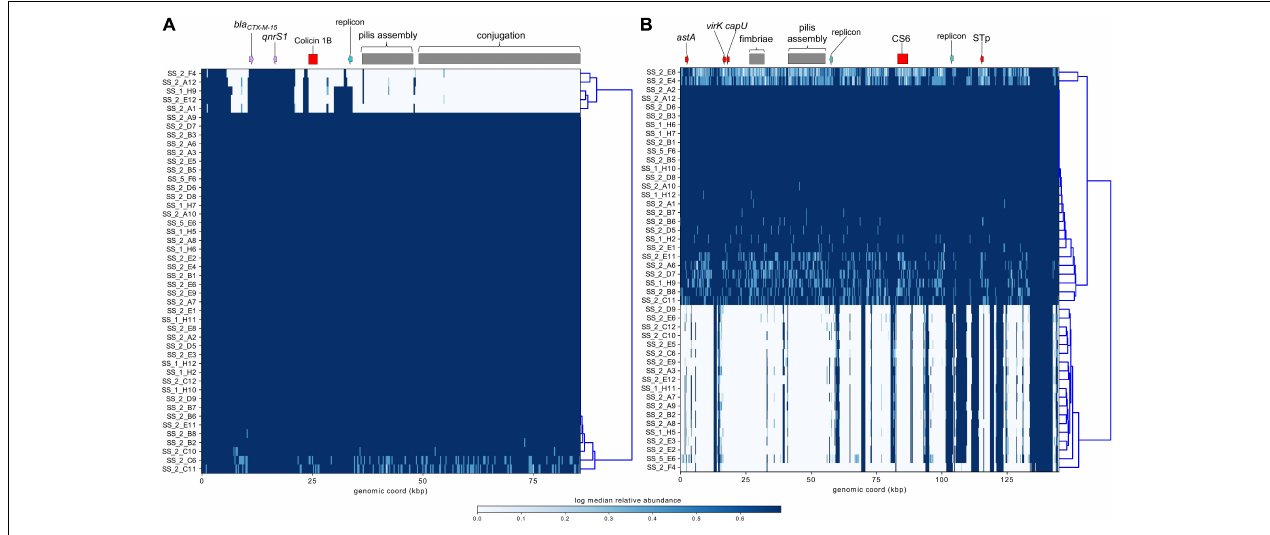
FIGURE 8 | Mapping of short-reads indicating the presence of IncB/O/K/Z and IncF plasmids. (A) Schematic and heatmap for IncB/O/K/Z plasmid from E. coli ST182 strain 2014EL-1345-2. (B) Schematic and heatmap for IncF plasmid from E. coli strain 2014EL-1345-2. Clustering of rows is based on the similarity between plasmid coverage profiles. Solid blue color indicates a read depth of over 20, and a light blue color indicates a read depth between 10 and